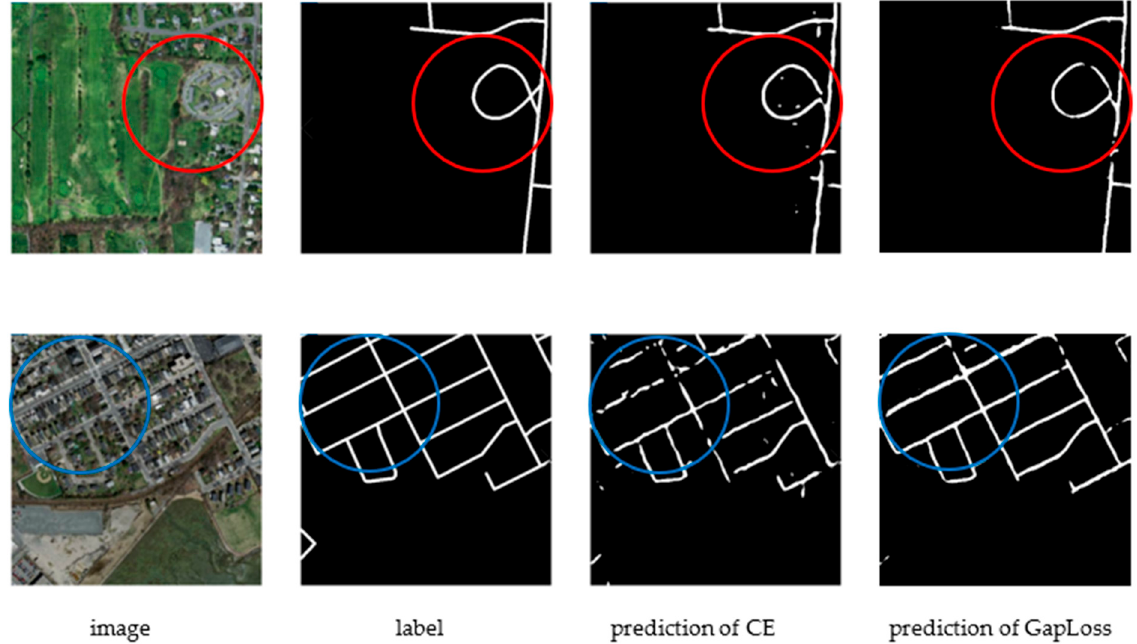
Figure 5. MUNet results with CE and GapLoss on Massachusetts Roads Dataset. The blue and red circles indicate where the road continuity is improved after using GapLoss.